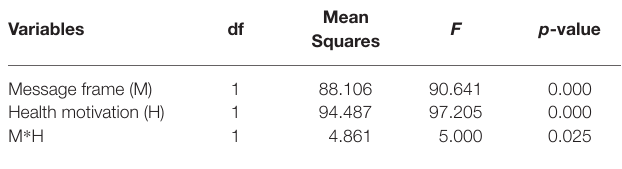
TABLE 5 | Moderating effect of health motivation on frame